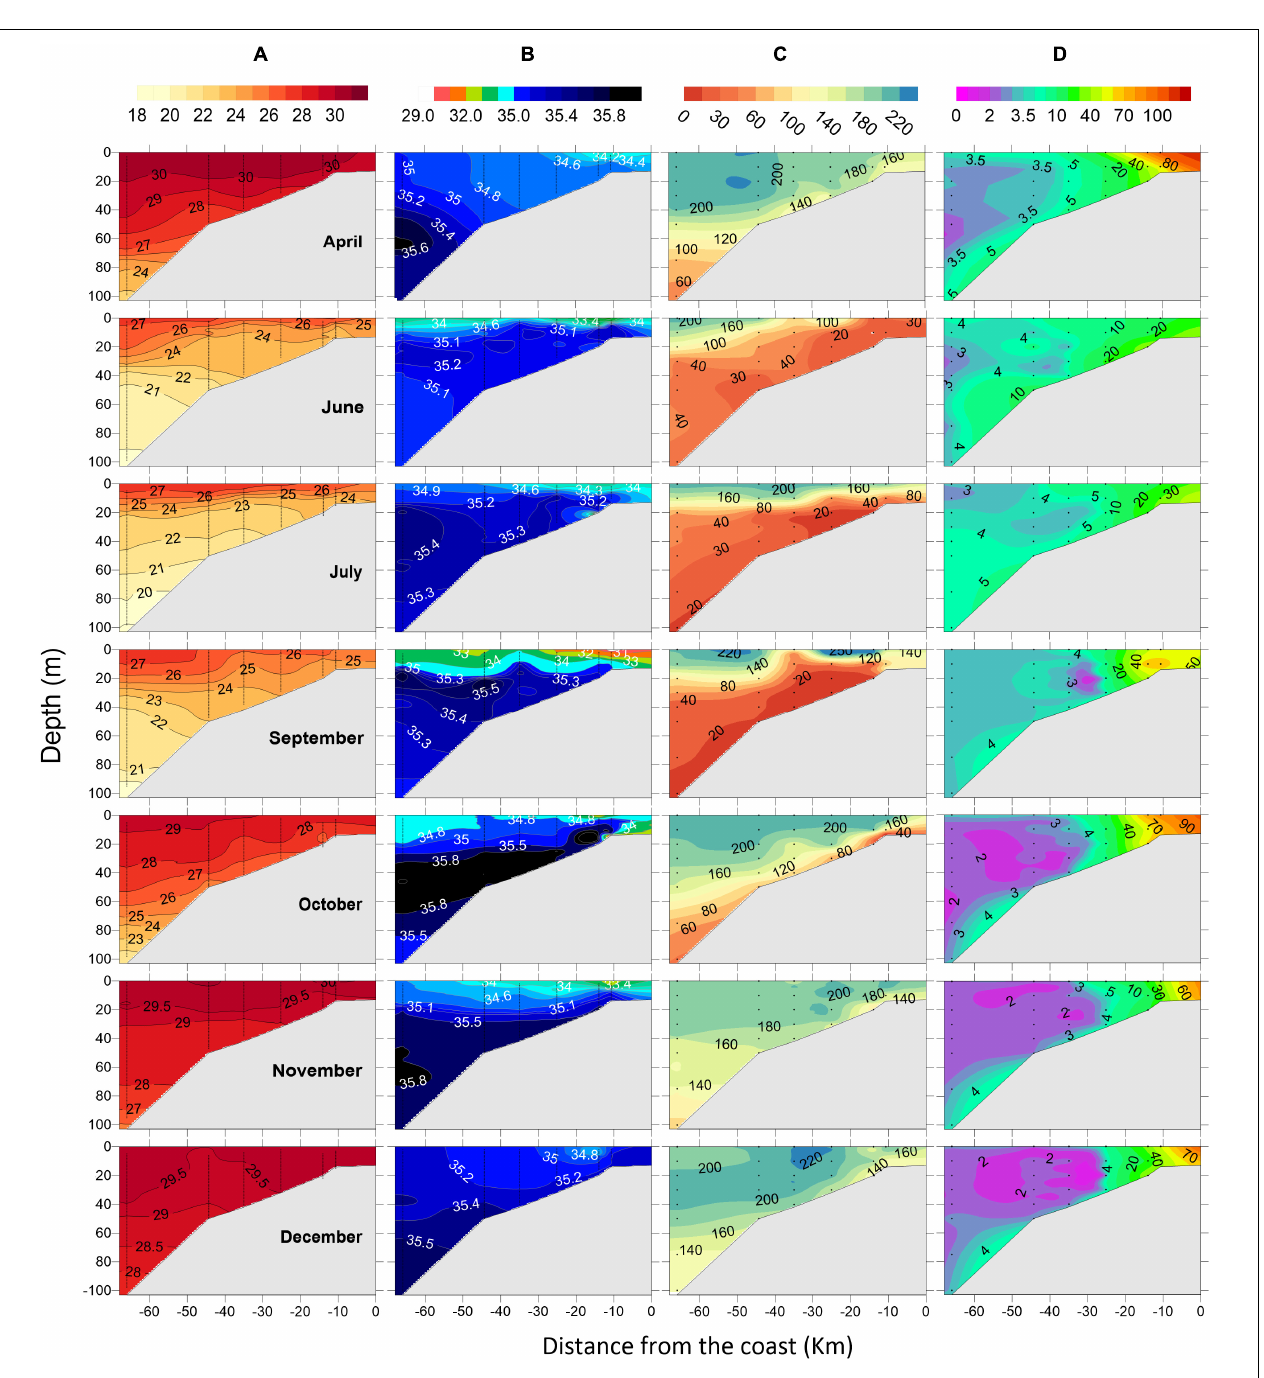
FIGURE 2 | Monthly distribution of (A) temperature ( ◦ C), (B) salinity, (C) dissolved oxygen ( µ M), and (D) methane (nM) off